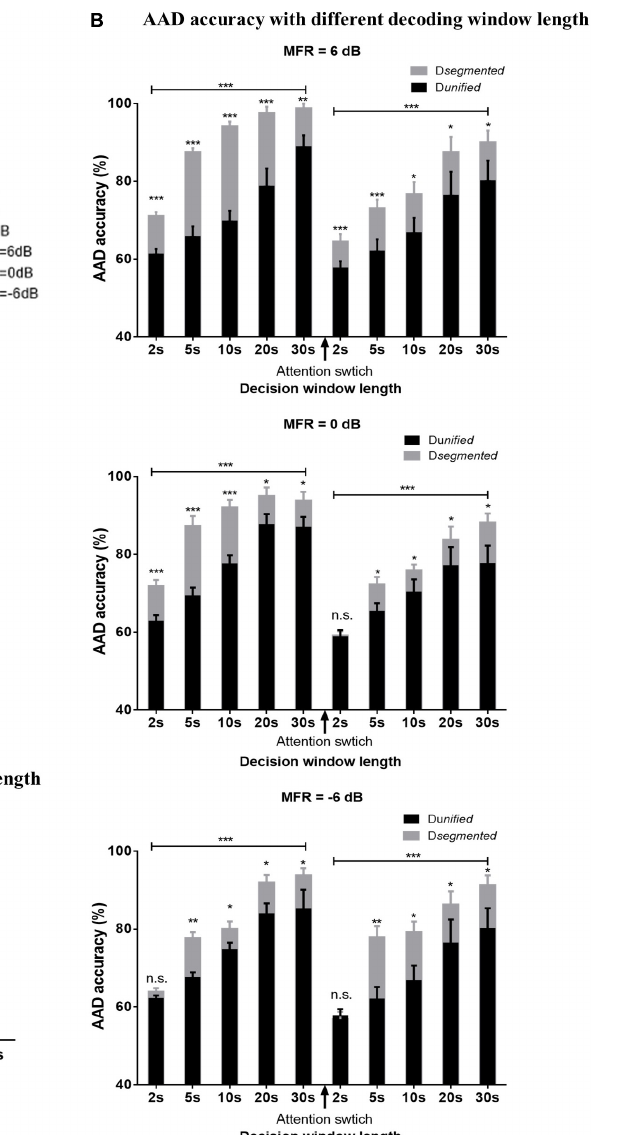
were no significant interactions of these three factors, and the interaction of decoding model by MFR level for both r tar and r ign values (all P > 0.05). A significant interaction was shown between MFR level and attention switching for the value of r tar [ F ( 2 , 30 ) = 5.19, P = 0.01, η 2 = 0.26] and r ign [ F ( 2 , 30 ) = 28.01, p = 0.65]. The attention switching exhibited a main P < 0.001, η 2 p effect on the value of r tar [ F ( 1 , 15 ) = 43.03, P < 0.001, η 2 = p